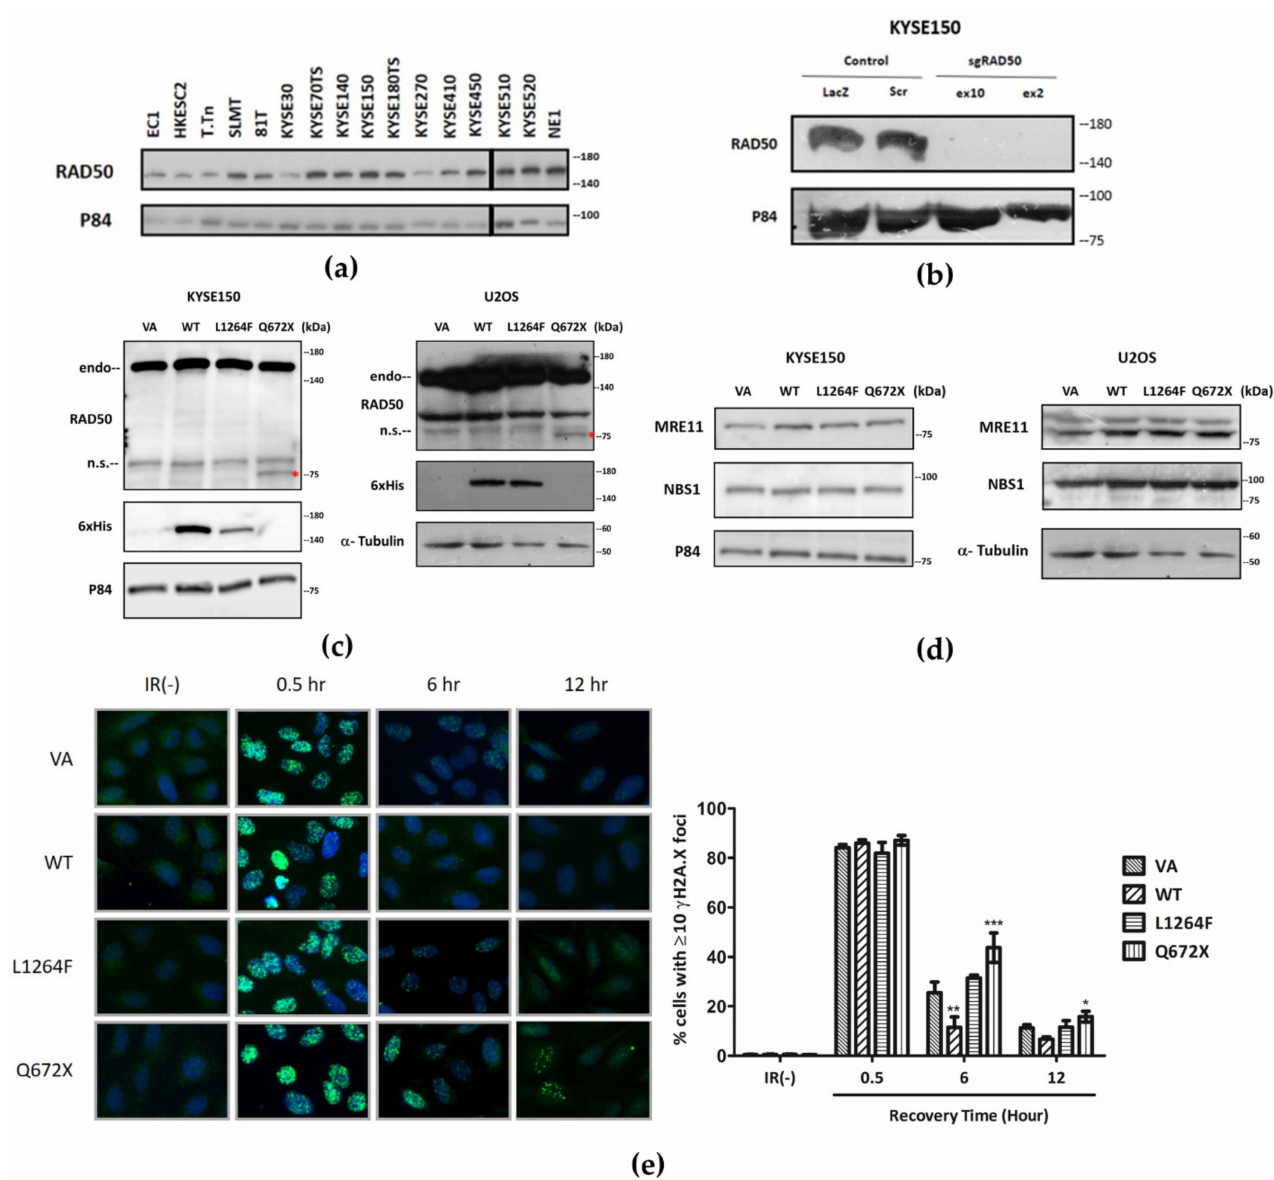
Figure 3. Dominant negative effect of DSB repair by overexpression of zinc hook RAD50 Q672X mutant. RAD50 ubiquitously expressed in ESCC cell lines ( a ); knockdown of RAD50 in KYSE150 ( b ); overexpression of RAD50 mutants in KYSE150 and U2OS ( c ) induced higher expression of MRE11 in KYSE150 and MRE11/NBS1 in U2OS ( d ); delay of DSB repair ability indicated by γ H2AX foci formation in RAD50 Q672X overexpression in U2OS after IR stimulation ( e ). *, **, *** indicate p < 0.05, 0.01, and 0.001, respectively. Endo: endogenous full-length RAD50, n.s.: nonspecific, Red asterisk: